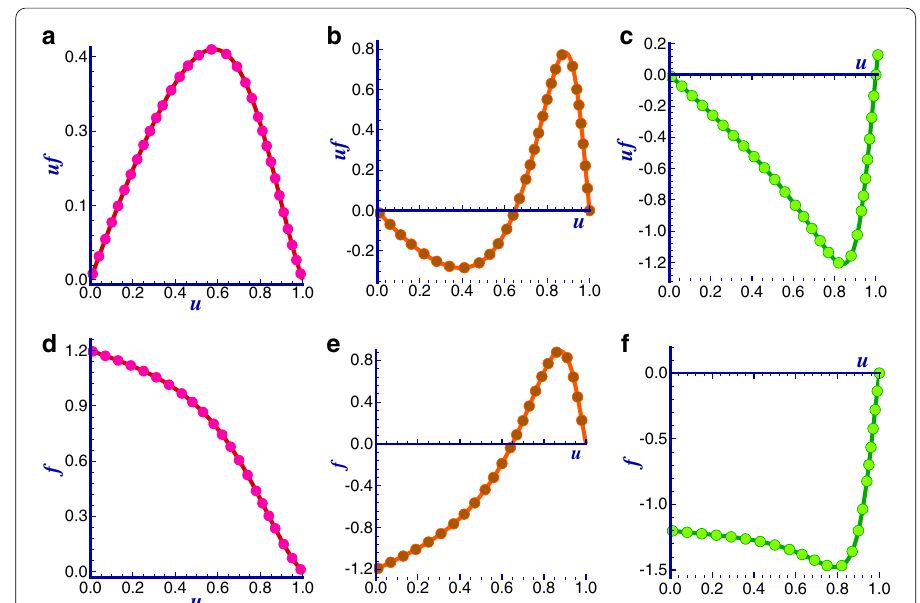
Fig. 2 The graphs on top row are growth rate uf ( t , x , u ), and the ones on lower row are growth rate per capita f ( t , x , u ), where a logistic for M cos (π x )) ; with K ( x ) ( 1.1 for M = − + follows